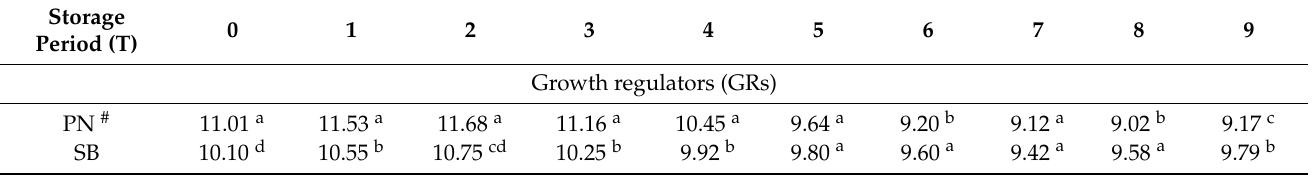
Table 4. Periodic changes in protein (mg/g FW) of onions under different GRs and water stress levels during 9 months of storage